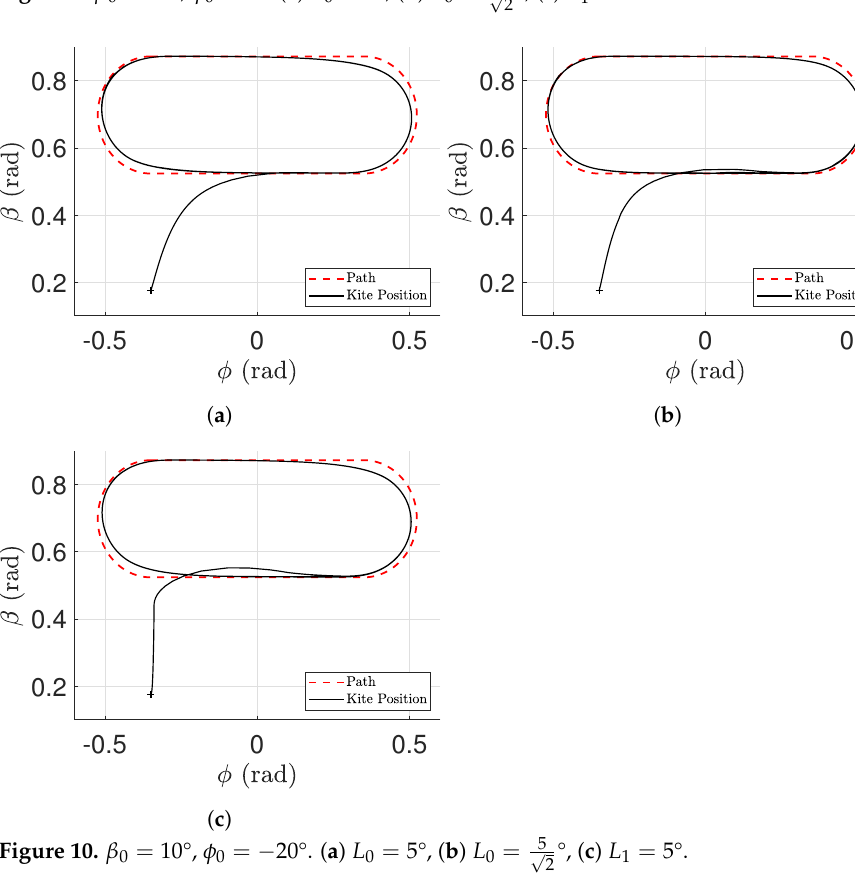
Figure 10. β 0 = 10°, φ 0 = − 20°. ( a ) L 0 = 5°, ( b ) L 0 = 5 √